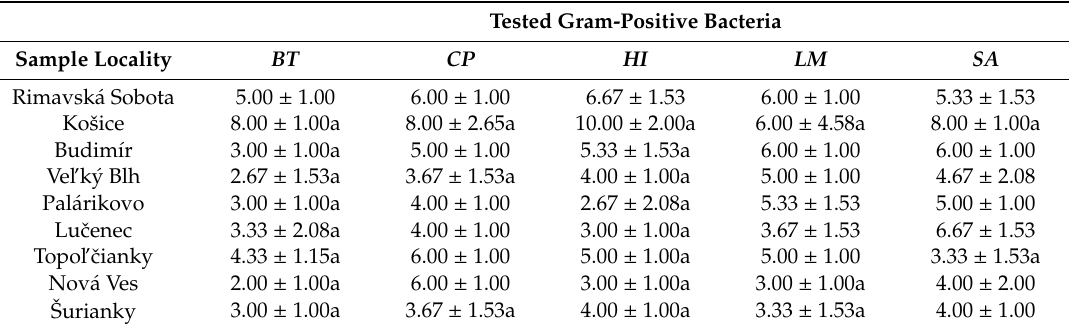
Table 4. Antimicrobial activity of Gingko biloba against Gram positive bacteria (in mm). Tested Gram-Positive